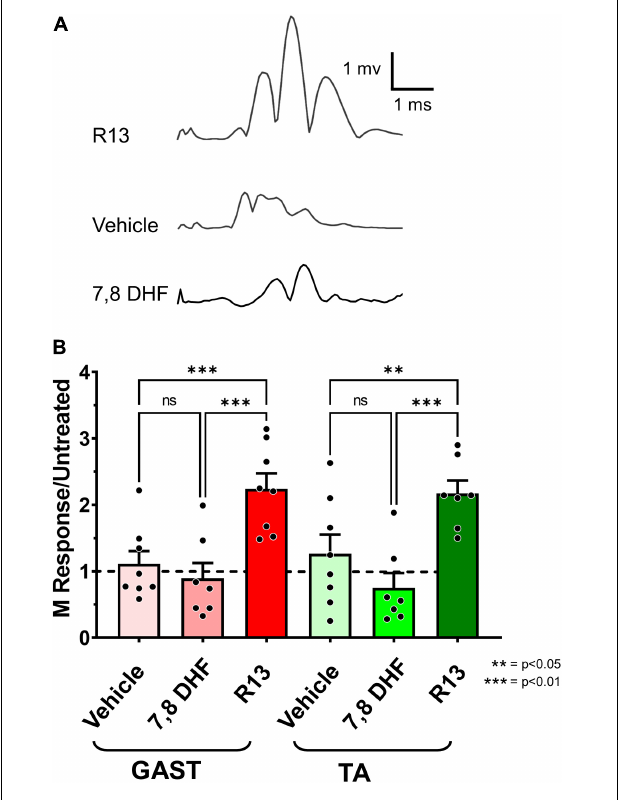
FIGURE 4 | (A) Direct muscle (M) responses recorded from gastrocnemius muscles in response to sciatic nerve stimulation are shown 4 weeks after sciatic nerve transection and repair from a mouse treated with oral R13 (upper trace), from a mouse treated with vehicle (middle trace), and from a mouse treated with oral 7,8-DHF (lower trace). (B) Mean ( ± SEM) scaled full wave rectified M response amplitudes recorded from gastrocnemius (GAST) and tibialis anterior (TA) muscles 4 weeks after sciatic nerve transection and repair and oral treatment with vehicle ( n = 8), 7,8-DHF ( n = 7), or R13 ( n = 7). The dashed horizontal line at unity represents the mean Mmax amplitude recorded from untreated mice 4 weeks after transection and repair of the sciatic nerve (Park et al., 2019). ** p < 0.01, *** p < 0.001.